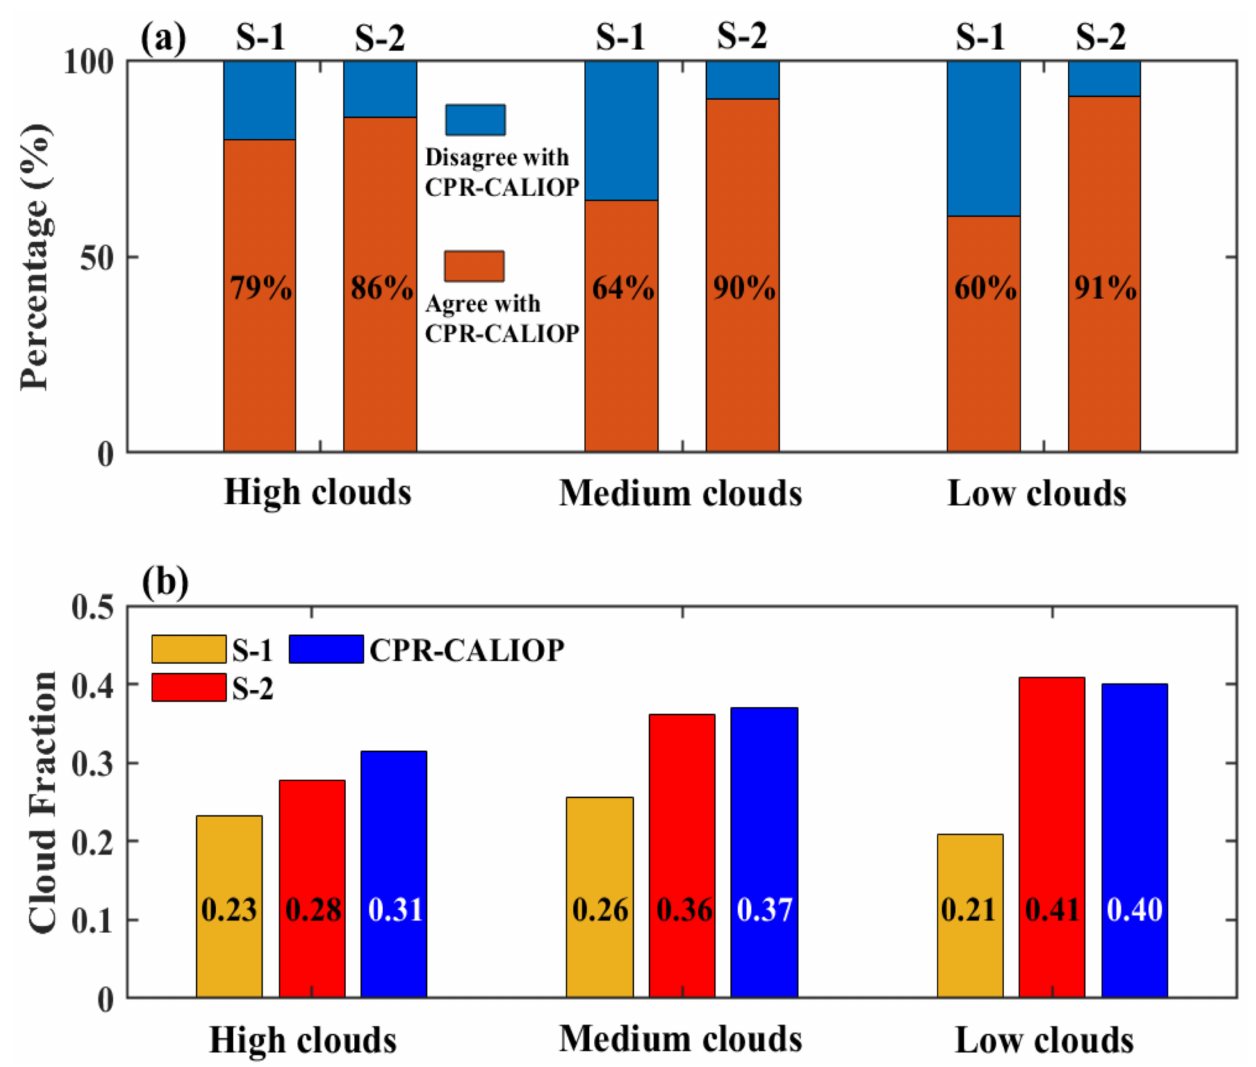
Figure 9. ( a ) Percentages of cloud classification results obtained by Schemes 1 (S-1) and 2 (S-2) that agree or disagree with the CPR-CALIOP measurements. ( b ) Annually mean fractions of high, medium, and low clouds from S-1, S-2, and the CPR-CALIOP measurements in